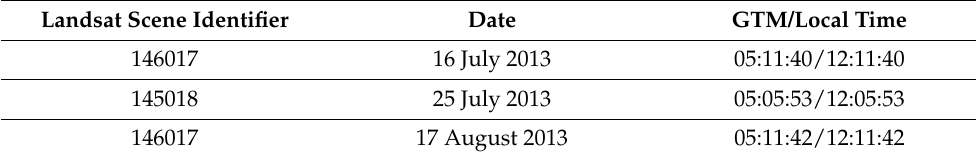
Table 2. Description of the scenes used by Landsat-8 Level-2 Science